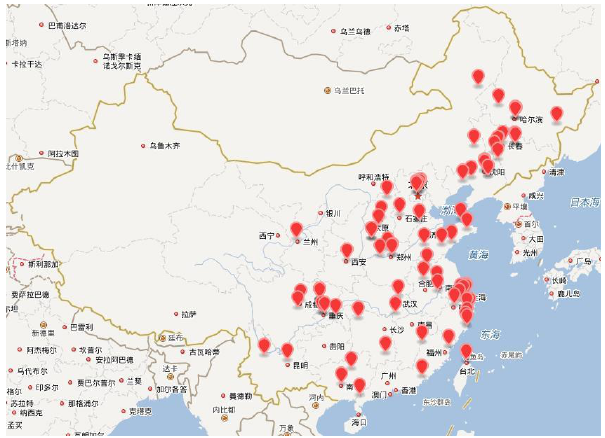
Figure 21. Geographical location distribution of the 88 webcasters’ latest login.